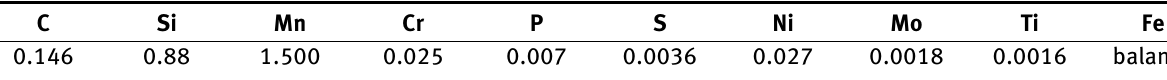
Table 1: Chemical composition (wt.%) of AHSS-DP800 steel